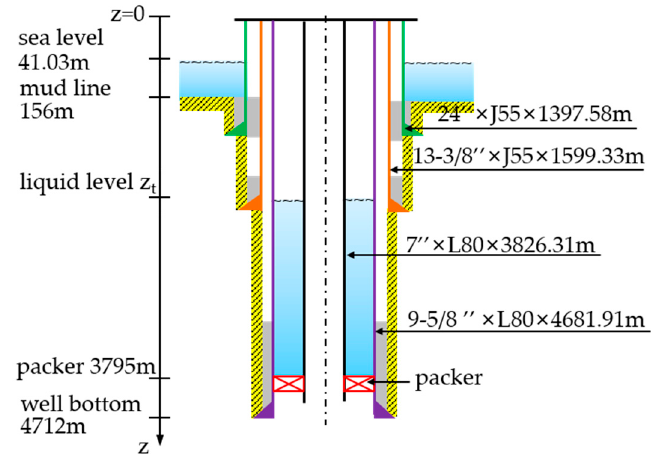
Figure 17. Schematic of the test CSG well.